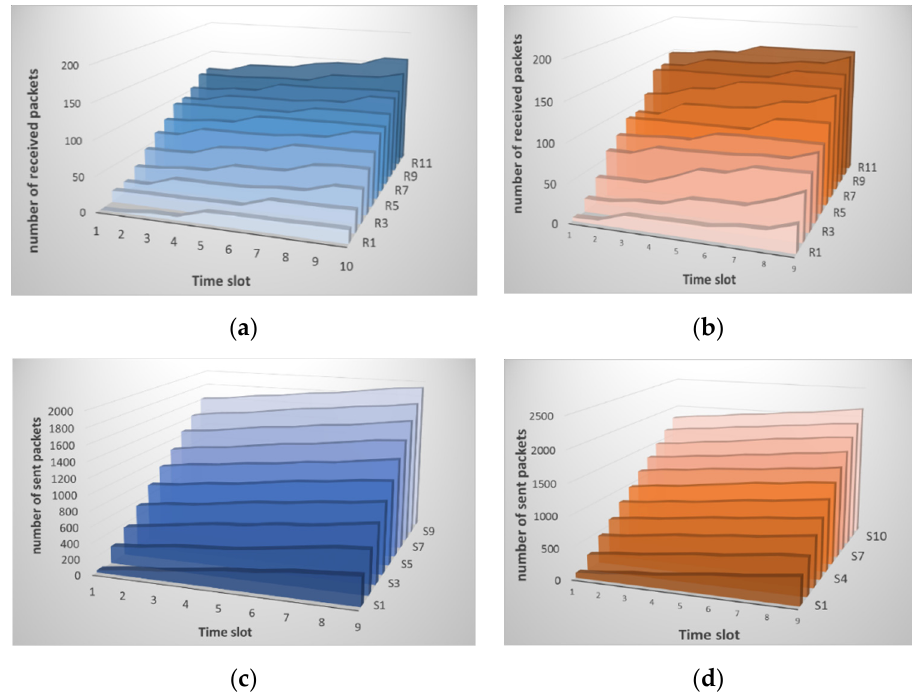
Figure 2. Changes in the traffic pattern when analyzing raw data on: ( a ) received packets of node i and ( b ) packets sent from node i ; ( c ) received packets from node j and ( d ) sent packets from node j during normal operation of the sensor network.